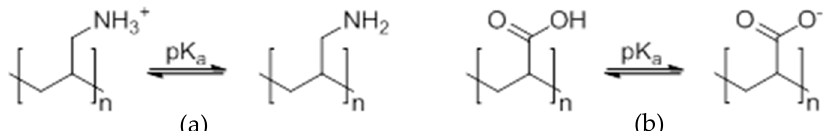
Figure 1. Chemical structure of: ( a ) poly(allylamine hydrochloride) (PAH) and ( b ) poly(acrylic acid) (PAA). Light transmittance of the solutions was measured with a Genesis10uv (Thermo Scientific, Madison, WI, USA) spectrophotometer at wavelength 700 nm, at 25 with an optical path of 10